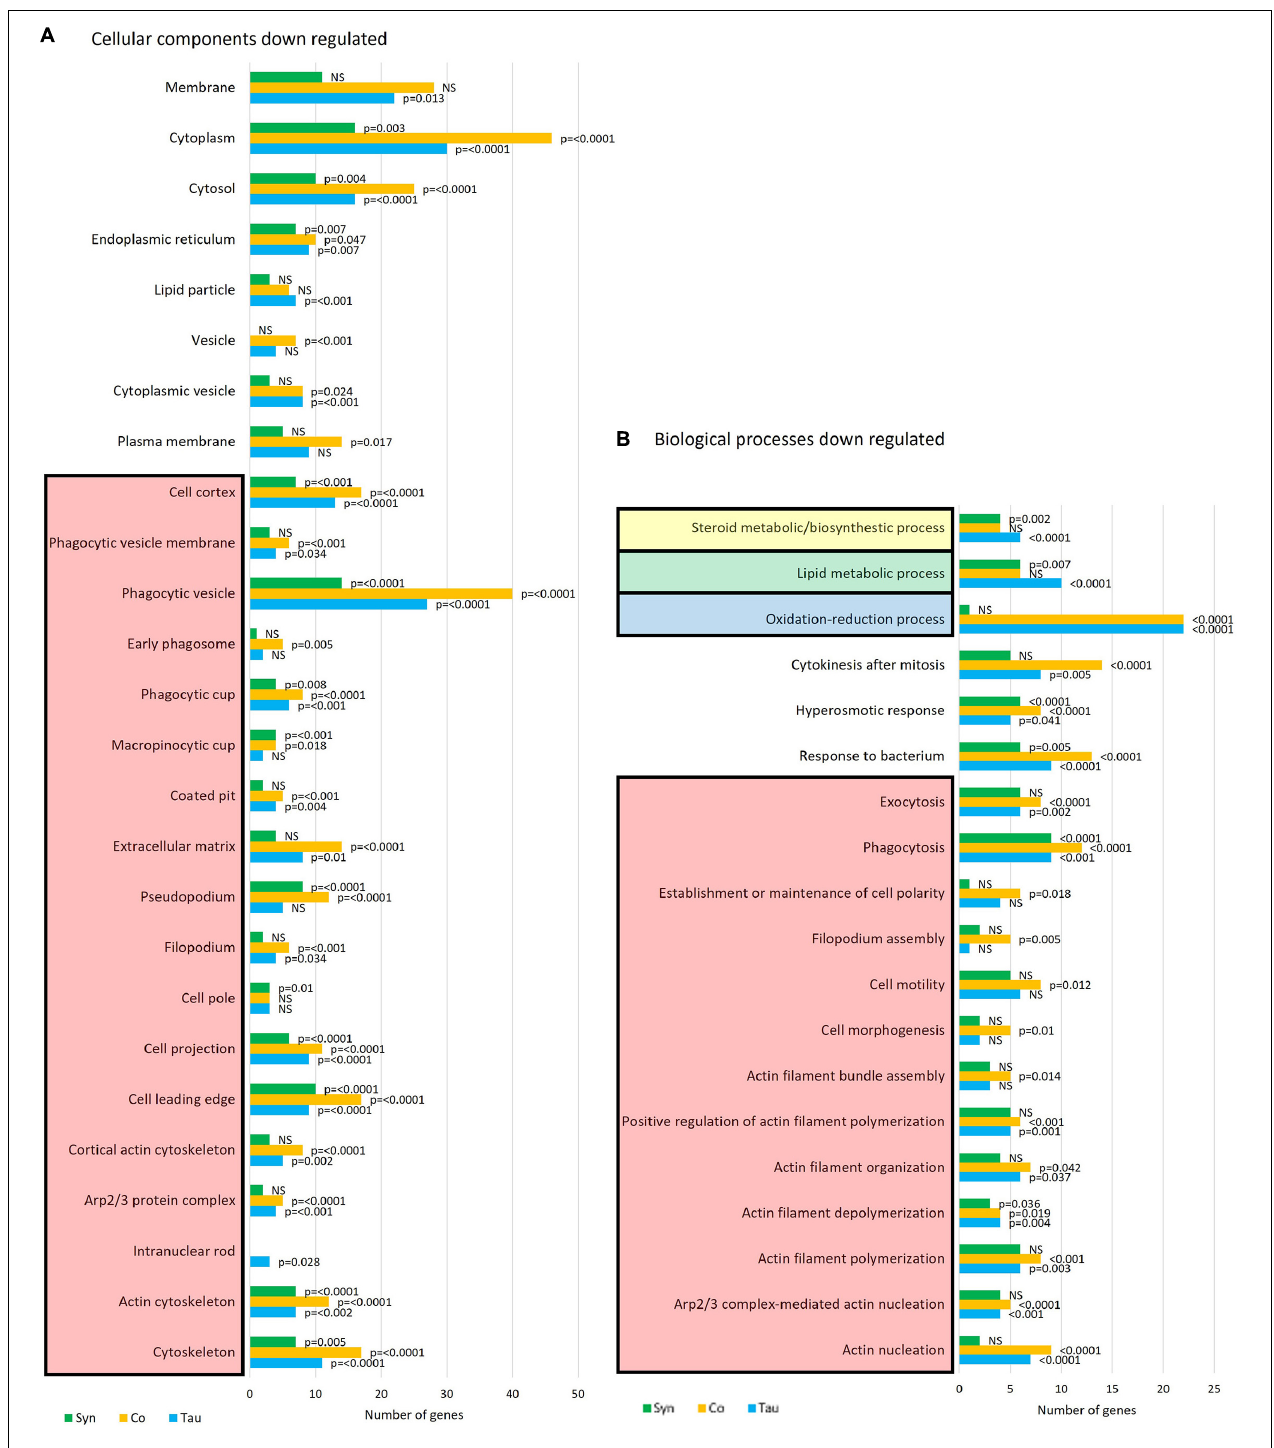
FIGURE 10 | Cellular components and biological processes down-regulated in strains expressing tau and/or α -synuclein. Funrich enrichment analysis of cellular components (A) and biological processes (B) indicate that the cytoskeleton is significantly down-regulated in all strains. The coexpression of tau and α -synuclein compounded the effect. The reported p -values are based on hypergeometric tests using the Bonferroni method of correction calculated in FunRich software. This is based on the number of proteins down-regulated within each strain divided by the total number of proteins generated for each process/component using the Gene Ontology database for D.